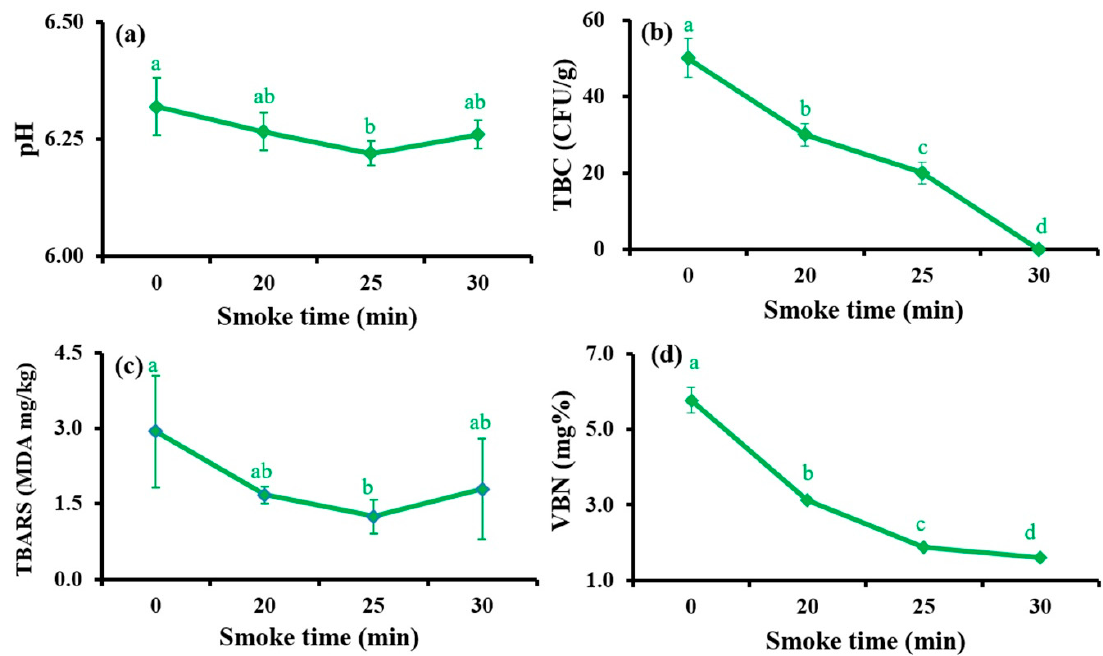
Figure 4. Changes of pH ( a ), total bacterial count (TBC) ( b ), thiobarbituric acid reactive substances (TBARS) ( c ), and volatile base nitrogen (VBN) value ( d ) in hot smoked CM fillet with different smoking times. The data were stated as mean ± std (n = 10), where different letters were statistically different ( p < 0.05).